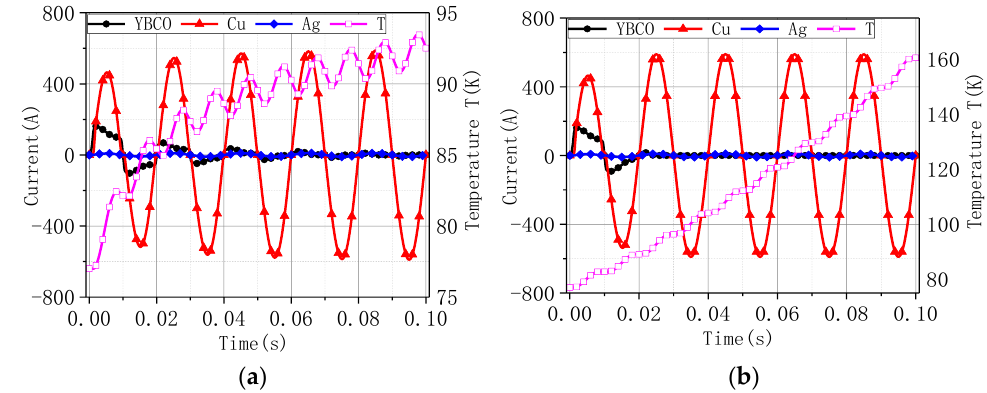
Figure 7. The current diversion and the highest temperature value under 600 A: ( a ) Model 1; ( b ) Model 2.